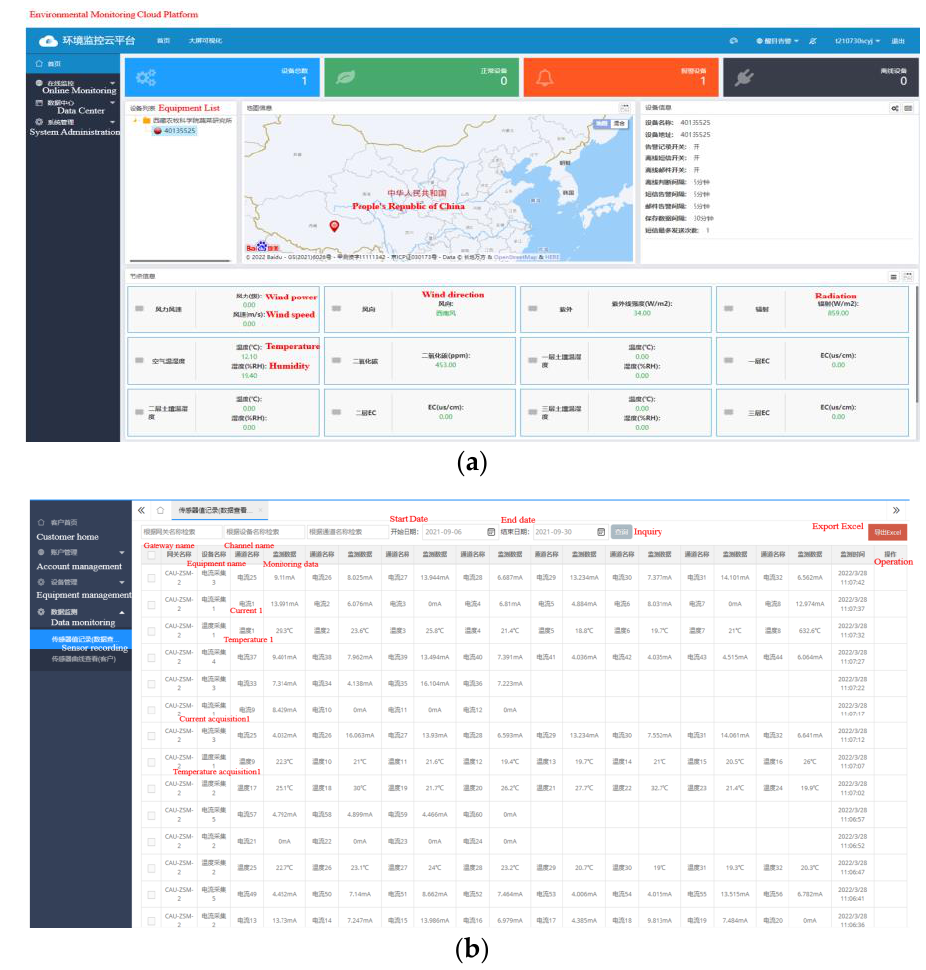
Figure 3. Internet-of-things transmission platform. ( a ) Platform of weather station. ( b ) Interior Sensor Platform.